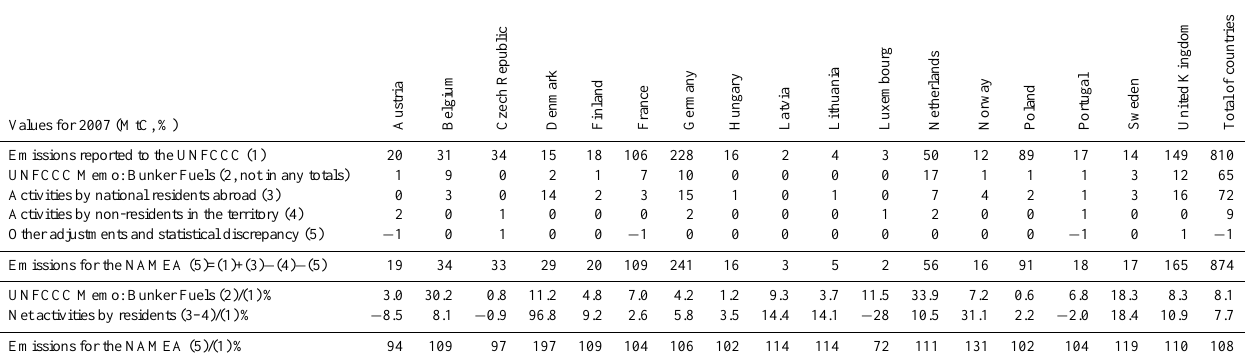
Table 4. The “bridge” table connecting the UNFCCC and NAMEA inventories for reporting European countries in 2007. By convention, the UNFCCC memo on bunker fuels is recorded but not included in national totals. According to the NAMEA (economic accounting), allocation should be based on resident institutes, and thus adjustments must be made primarily for bunker fuel use when converting from a UNFCCC inventory to a NAMEA. The last set of rows shows the percentages relative to the UNFCCC totals. In most cases the NAMEAs are higher as they include international transport, while the UNFCCC inventories do